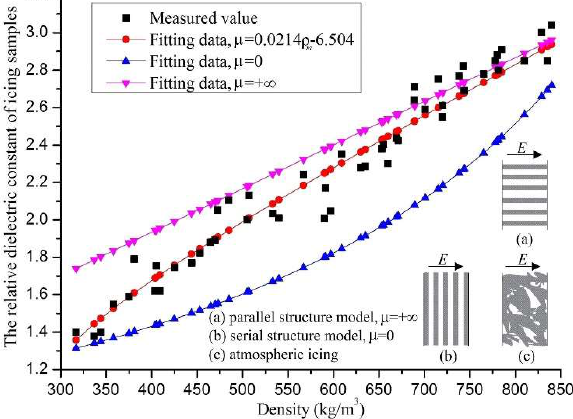
Figure 9. The relative dielectric constant of the icing samples with µ = 0.0214 ρ m −